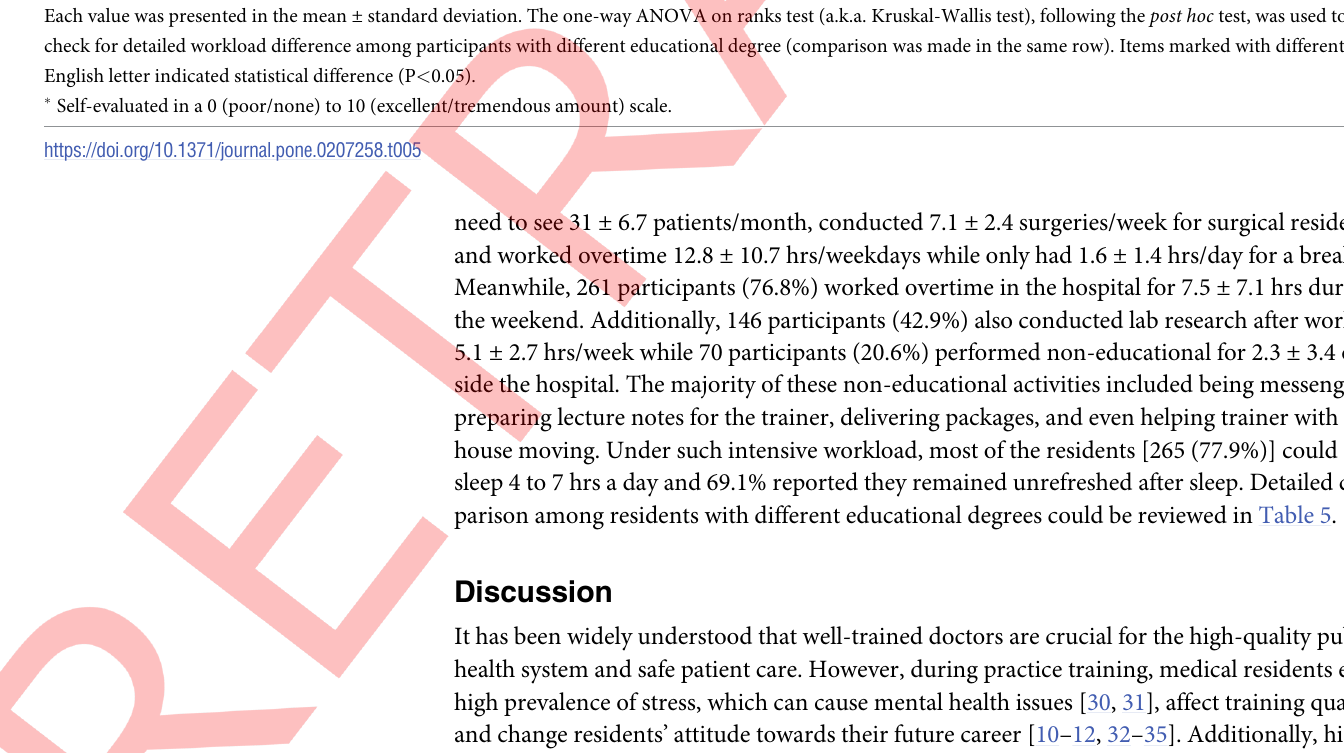
Report to feel refreshed after sleeping? (answered